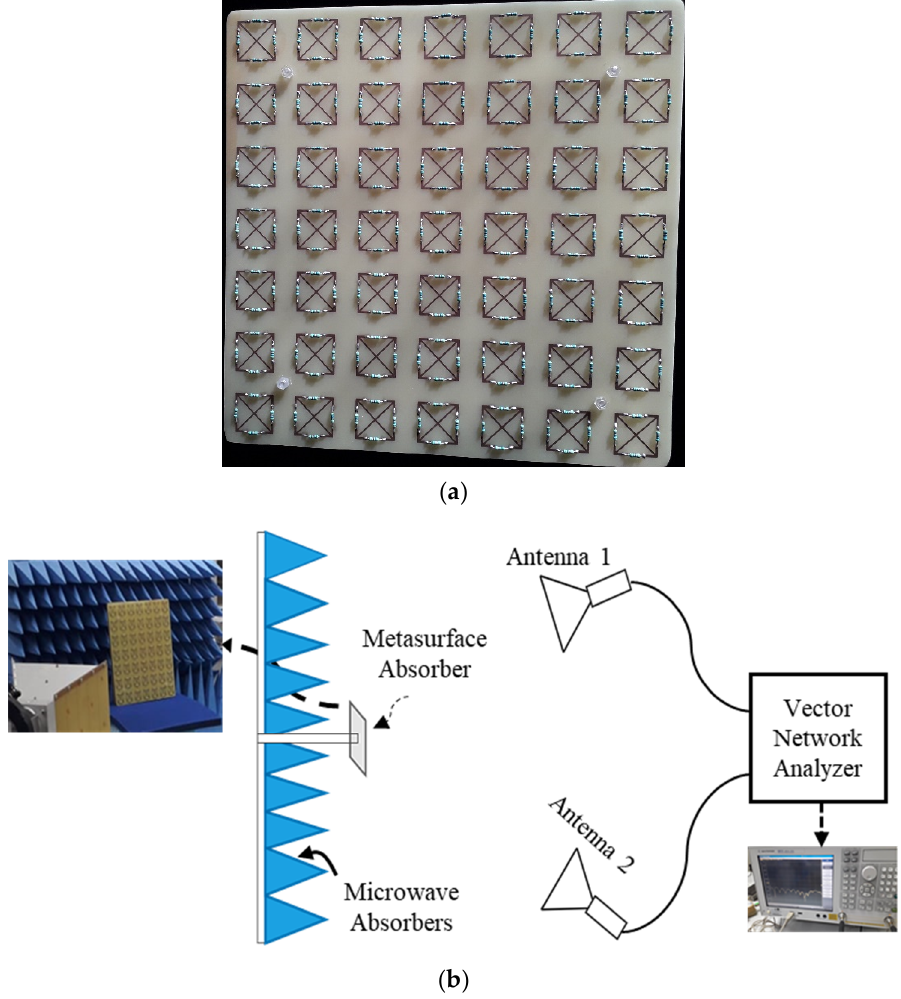
Figure 9. ( a ) Fabricated prototyped of MS absorber and ( b ) measurement setup.